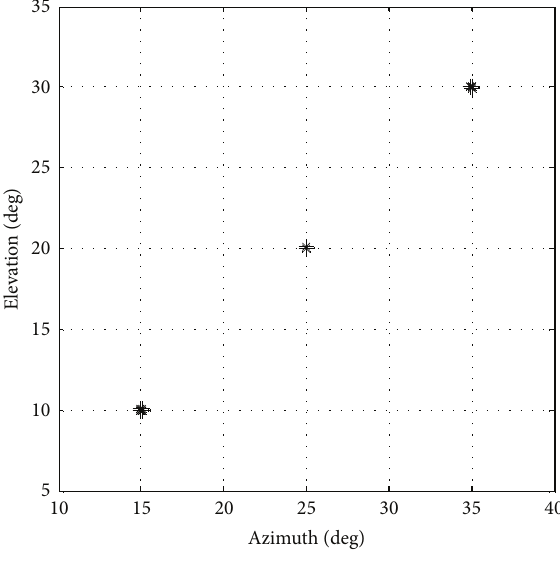
Figure 4: Angle estimation performance of the proposed algorithm with SNR = 20 dB.